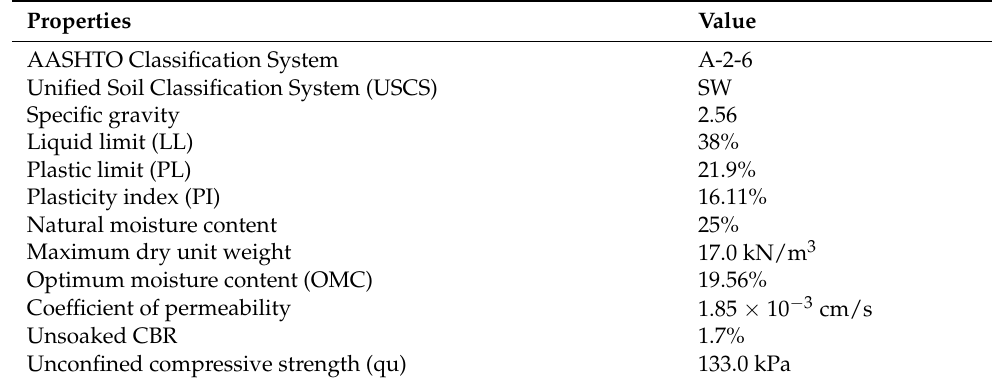
Table 2. Geotechnical properties of the natural soil.